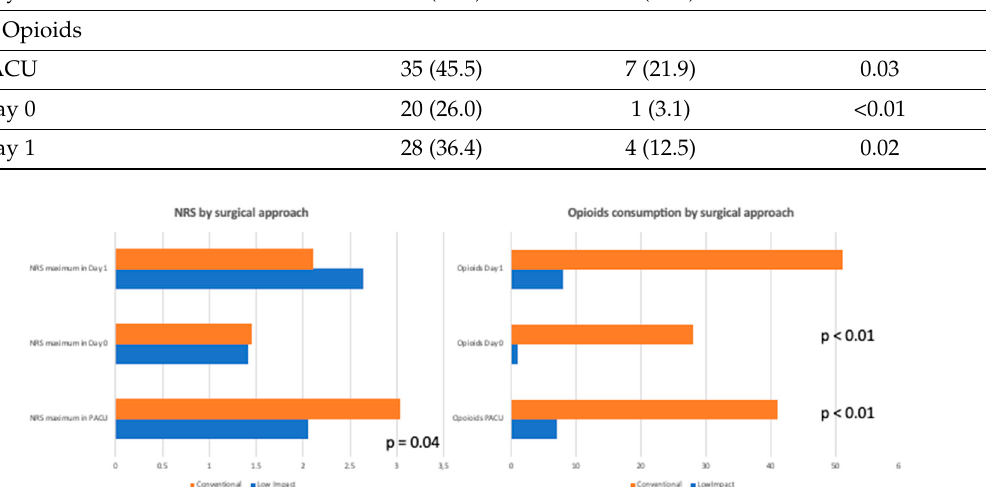
Figure 1. Postoperative opioid consumption and pain evaluation by surgical approach. Two factors were predictive of lower postoperative opioid consumption: a